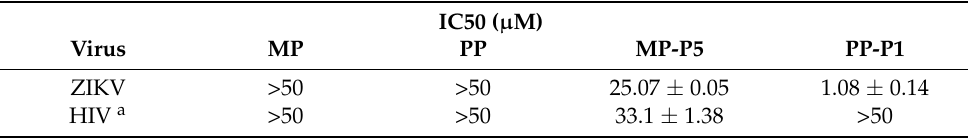
Table 2. PPCs antiviral activity in vitro .